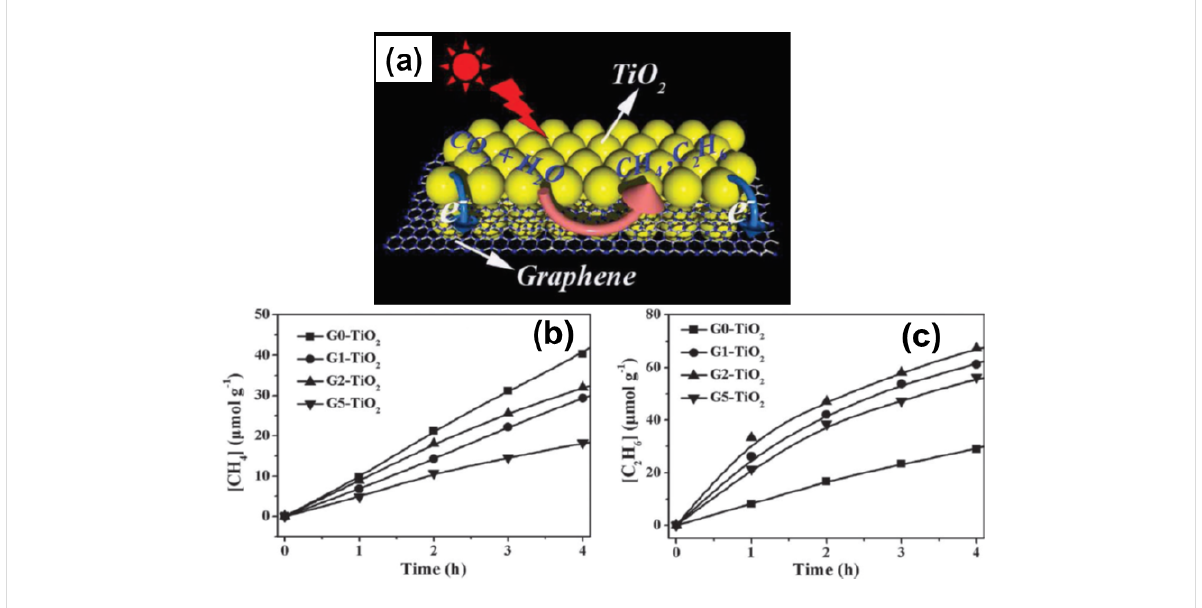
Figure 2: (a) Schematic illustration of the charge separation and transfer in the 2D sandwich-like graphene–TiO 2 nanostructure system and photore- duction of CO 2 into CH 4 and C 2 H 6 . (b) Photocatalytic CH 4 and (c) C 2 H 6 evolution amounts for samples G x TiO 2 ( x = 0, 1, 2, 5). The weight contents of graphene designated as x (wt %). Reproduced with permission from [90], copyright 2013 Wiley-VCH Verlag GmbH & Co.